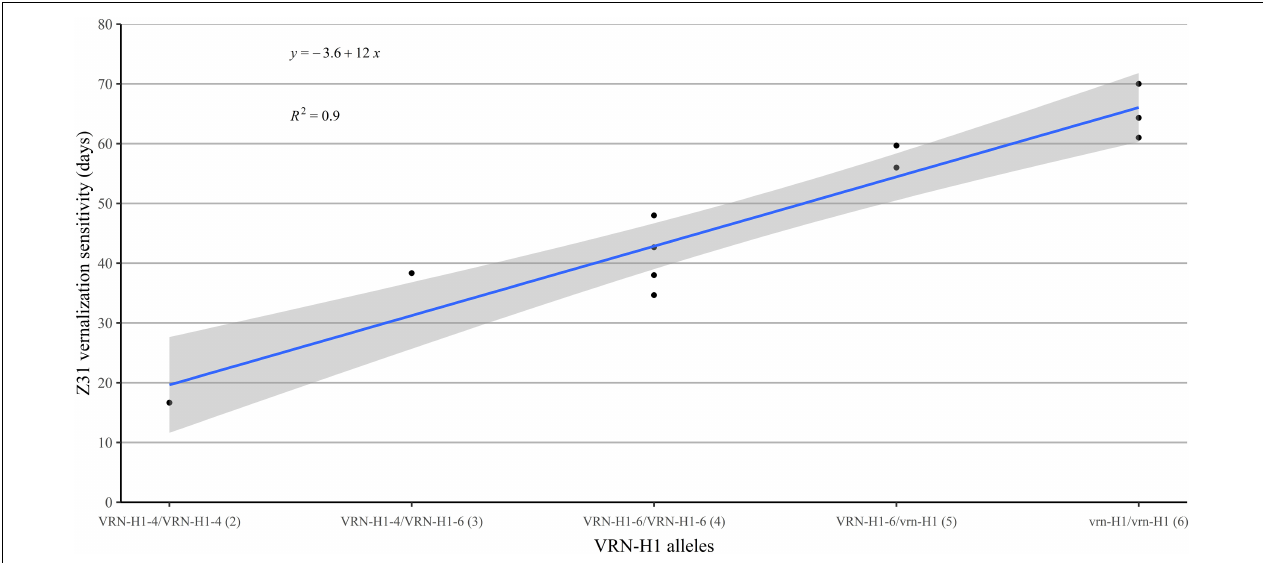
FIGURE 3 | Regression of vernalization sensitivity (duration until Z31 at V2 minus duration until Z31 in V8) on the allelic constitution at VRN-H1 , coded as 1 ( VRN-H1-4 ), 2 ( VRN-H1-6 ), or 3 ( vrn-H1 ), proportional to the vernalization requirement induced by each allele. The number within brackets indicates the vernalization requirement score of the genotype, according to their VRN-H1